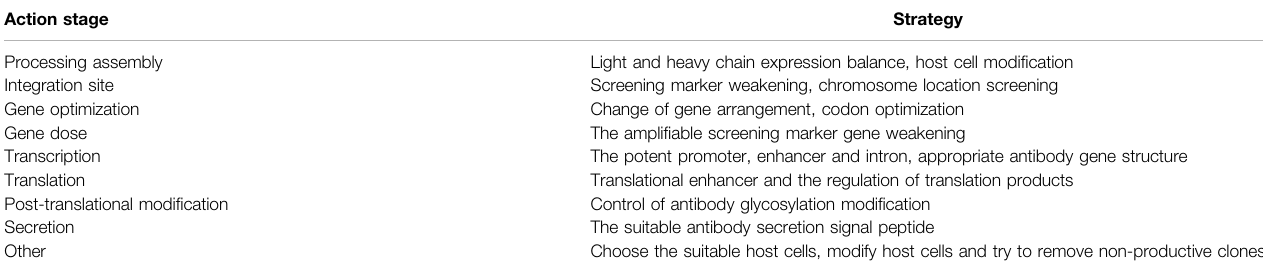
TABLE 3 | Basic strategies for improving recombinant antibody production and quality in CHO cells.